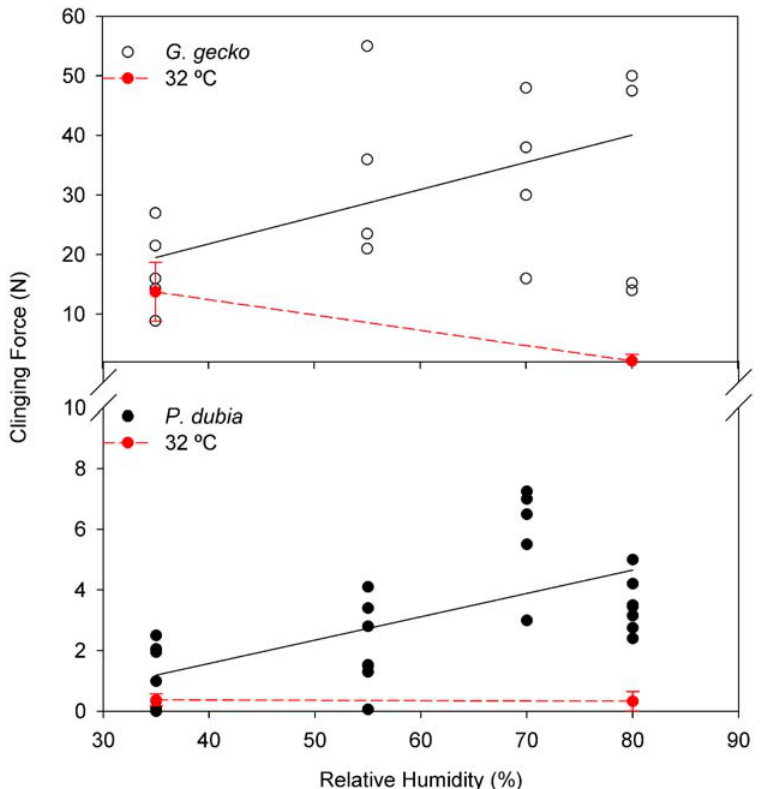
Figure 2. Adhesion at constant temperature of 12 u C and variable relative humidity (RH). Adhesion increased significantly with RH, but slopes were not significantly different. Red lines and symbols show results of 35% and 80% trials at 32 u C designed to test for an interaction of temperature and humidity; error bars represent 6 2 SE. See text for details (materials and methods).